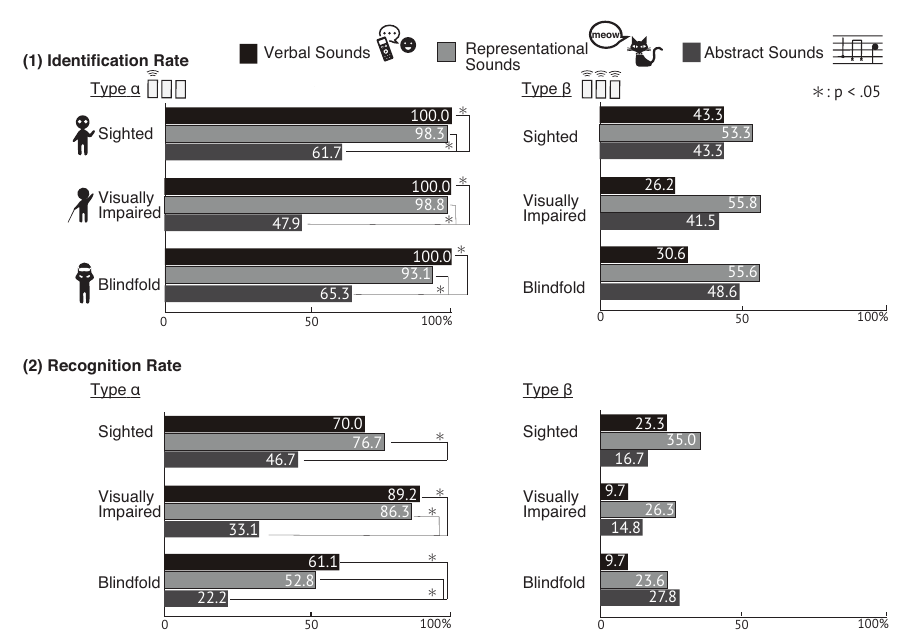
Figure 8. Differences in performance by audio types.